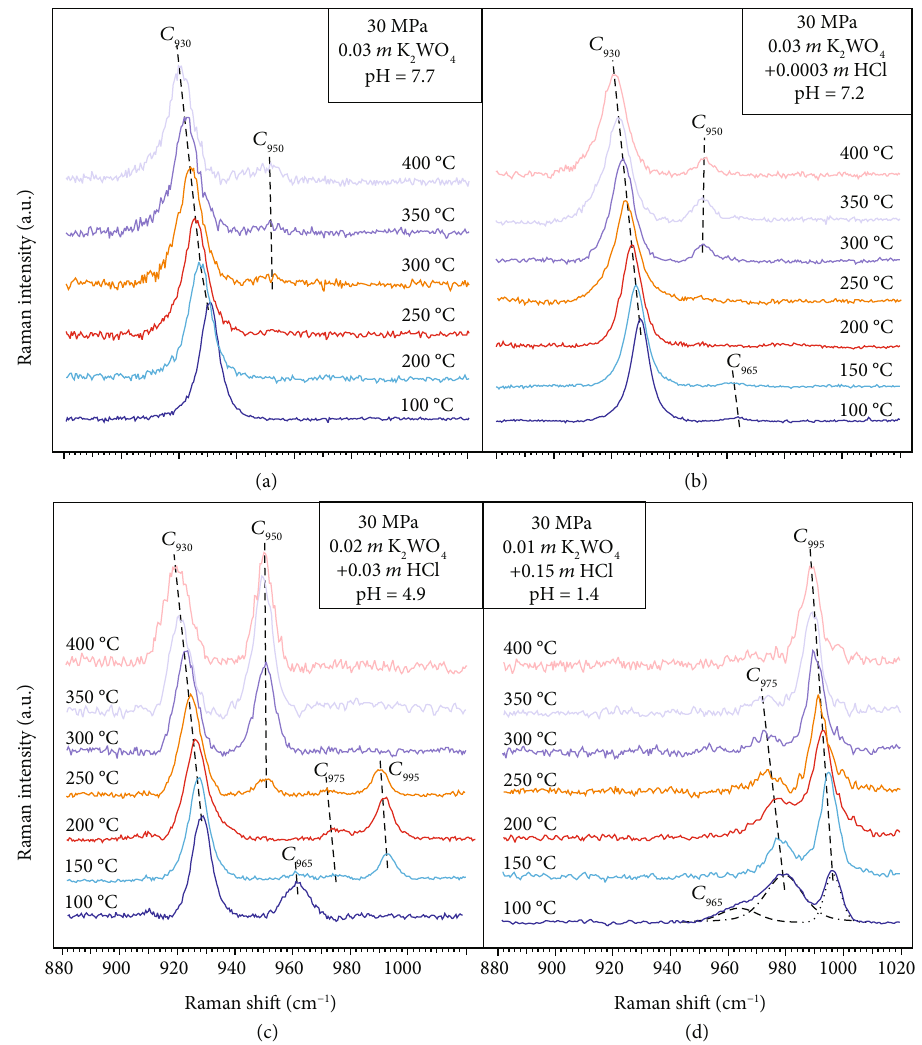
Figure 2: In situ Raman spectra of the K and initial pH of 7.7; (b) near-neutral solution with 0.03 m K WO +0.03 m HCl and initial pH of 4.9; and (d) highly acidic solution with 0.01 m K 0.02 m K 2 4